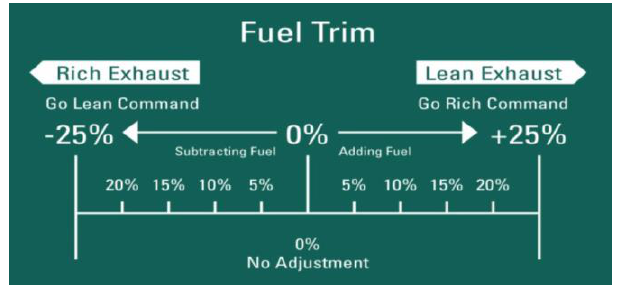
Fig. 1. Tuning the size of the fuel dose to the needs of the combustible mixture formed with an excess air ratio of λ = 1